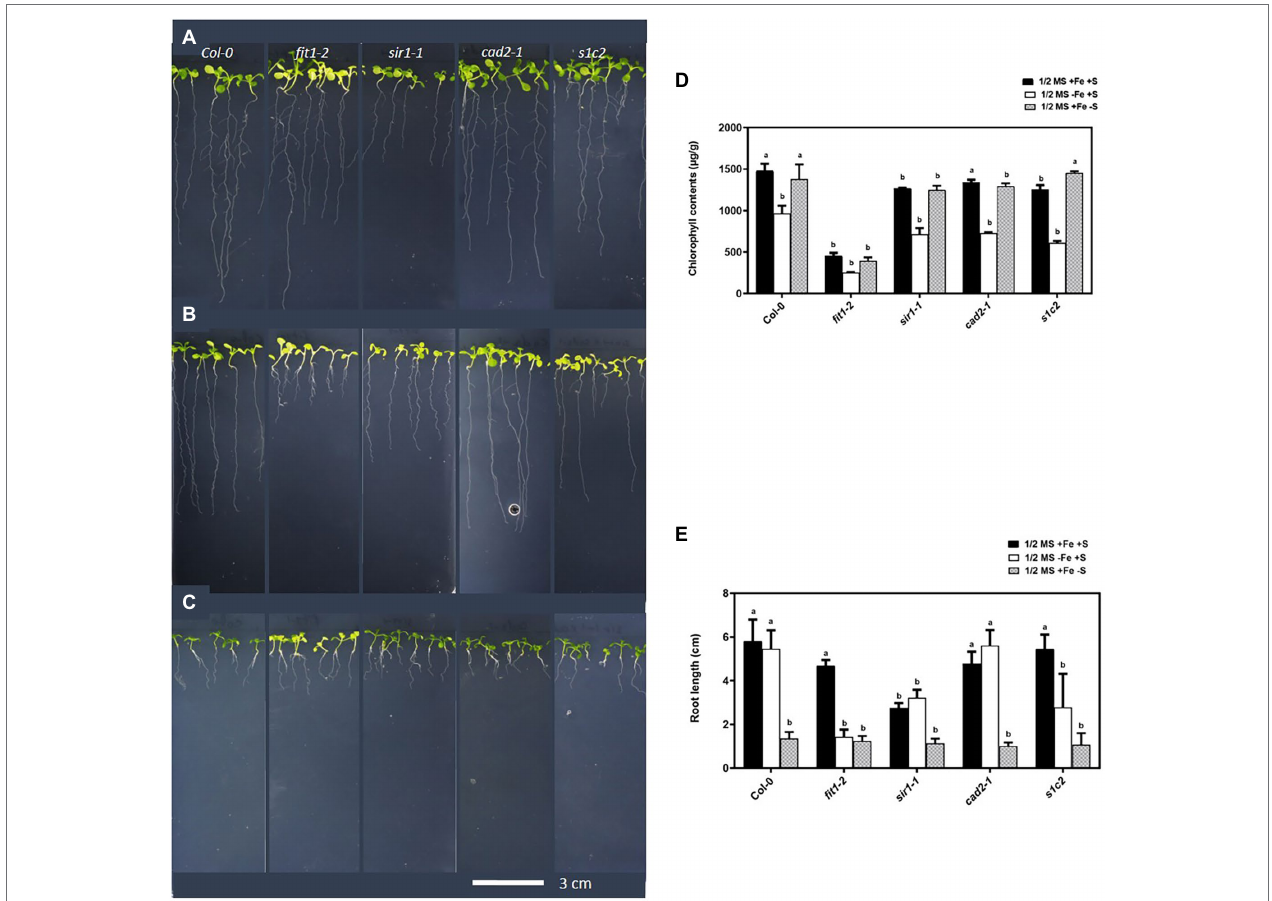
FIGURE 1 | Phenotype of Arabidopsis seedlings exposed to Fe and S starvation. Top view of the 1-week old seedlings transferred to: (A) half-strength MS medium (1/2 MS), (B) 1/2 MS − Fe, (C) 1/2 MS − S for 4 days under long-day conditions. (D) Chlorophyll contents, (E) root length. Letters indicate the statistically significant differences between the wild type (Col-0) on ½ MS + Fe + S with the other treatments in Col-0 and mutants, determined with the two-way ANOVA test followed by Dunnett’s test ( p < 0.05, n =